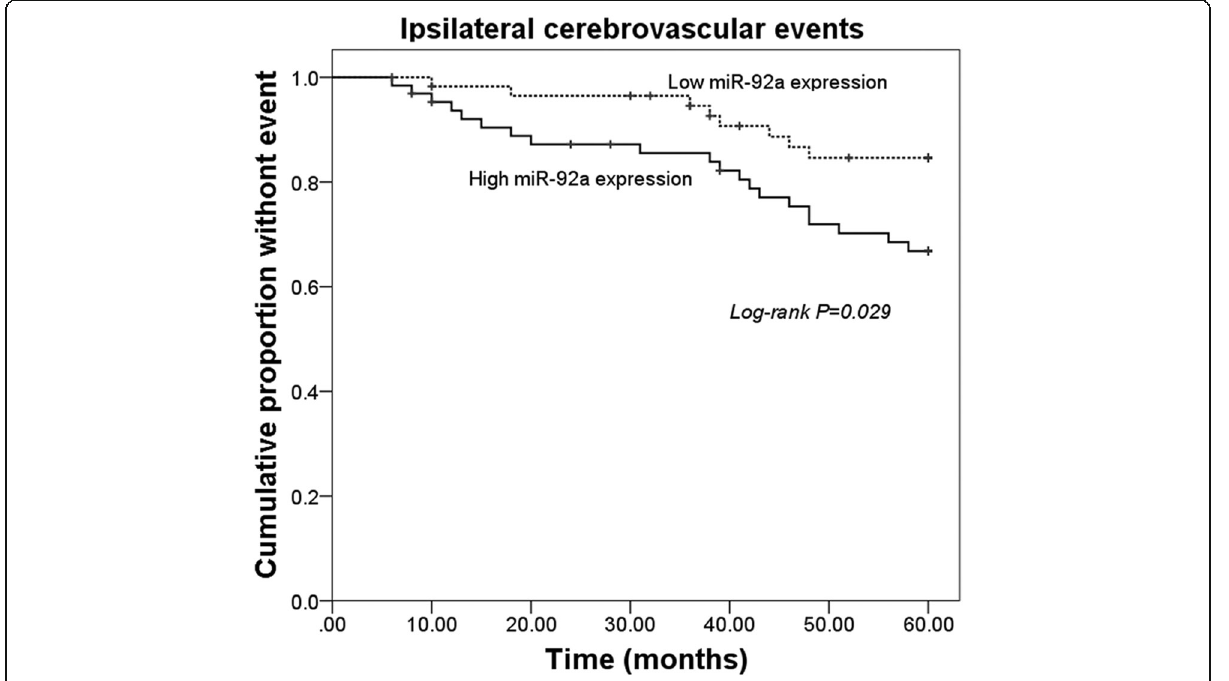
Fig. 3 Kaplan-Meier survival curves for ACAS patients with different expression levels of miR-92a. Log-rank P = 0.029